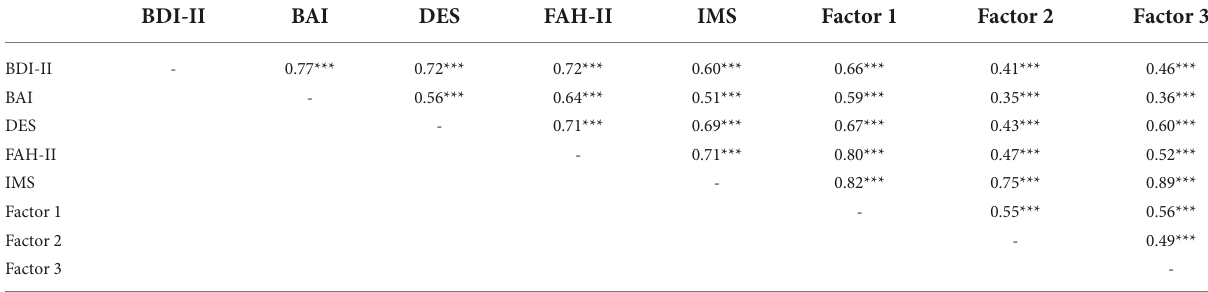
TABLE 4 Pearson’s correlations between the sum scores of used questionnaires measuring depressive symptoms, anxiety symptoms, depressive expectations, and psychological inflexibility as well as the sum score of the immunization scale (IMS) and the three factors of the IMS negative expectations, assimilation, and cognitive immunization (study